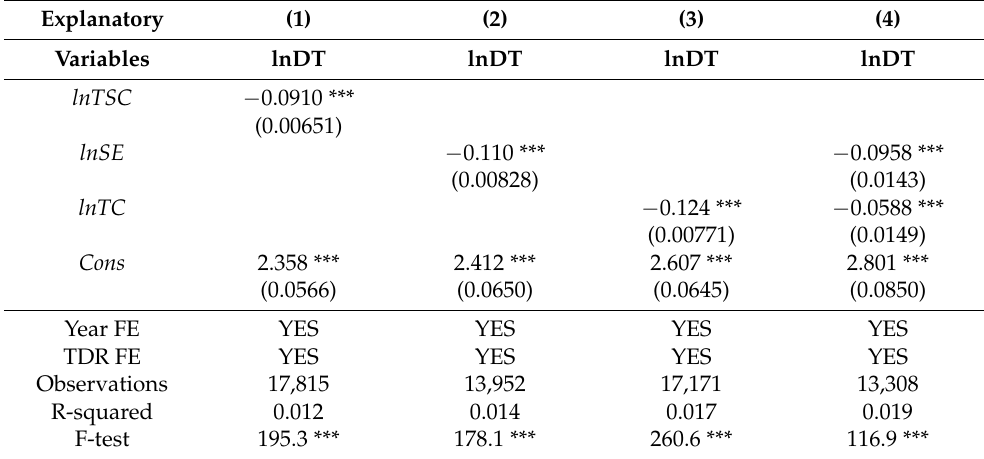
Table 6. TSC effect of HSR on destination development (5 h).